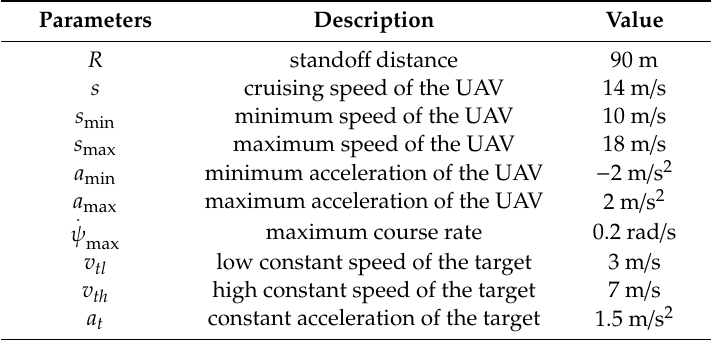
Figure 19. The target trajectories and moving speed in the simulation environment. All key parameters in the HIL simulation are listed in Table 2. Table 2. Key parameters in the HIL simulation.